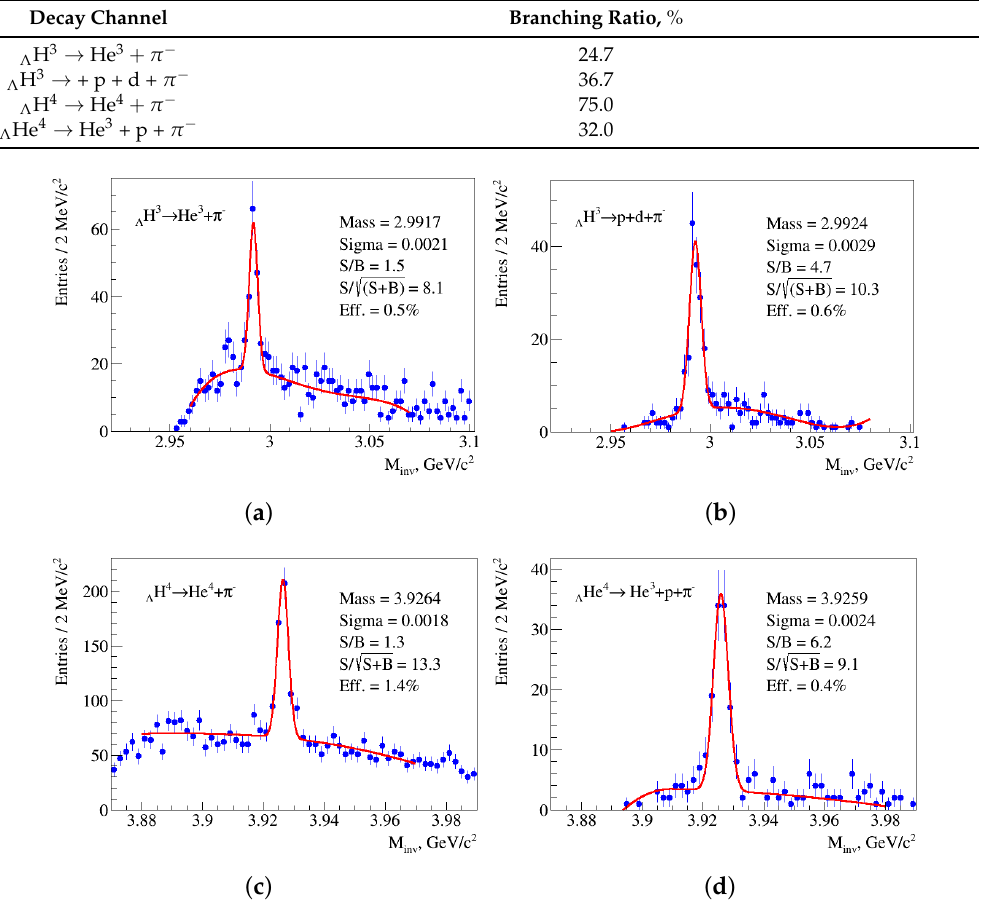
Figure 7. Reconstructed invariant mass spectra of hypernuclei decay products: ( a ) Λ H 3 → He 3 + π −